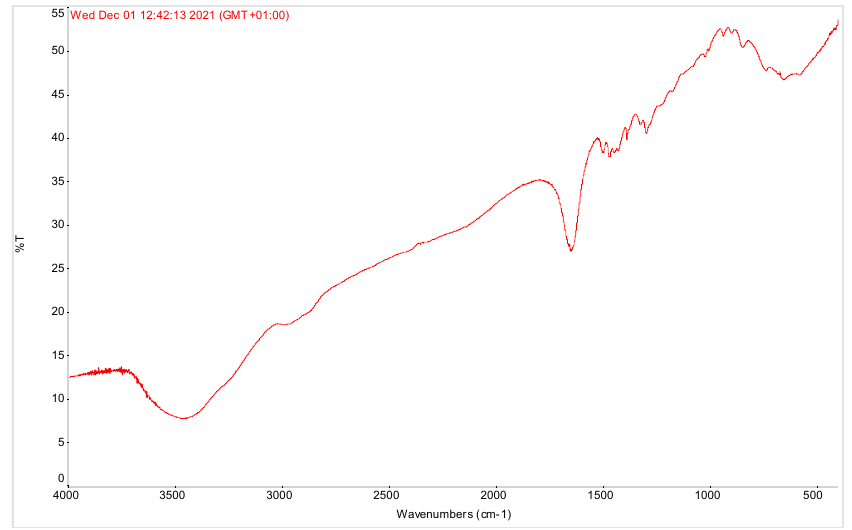
Figure 2. FT-IR profile of the EO-b-CD complex embedded in the PVP excipient matrix. In Figure 3, the diagnostic TGA profiles of the essential oil (A), b-CD (B), and EO-b-CD